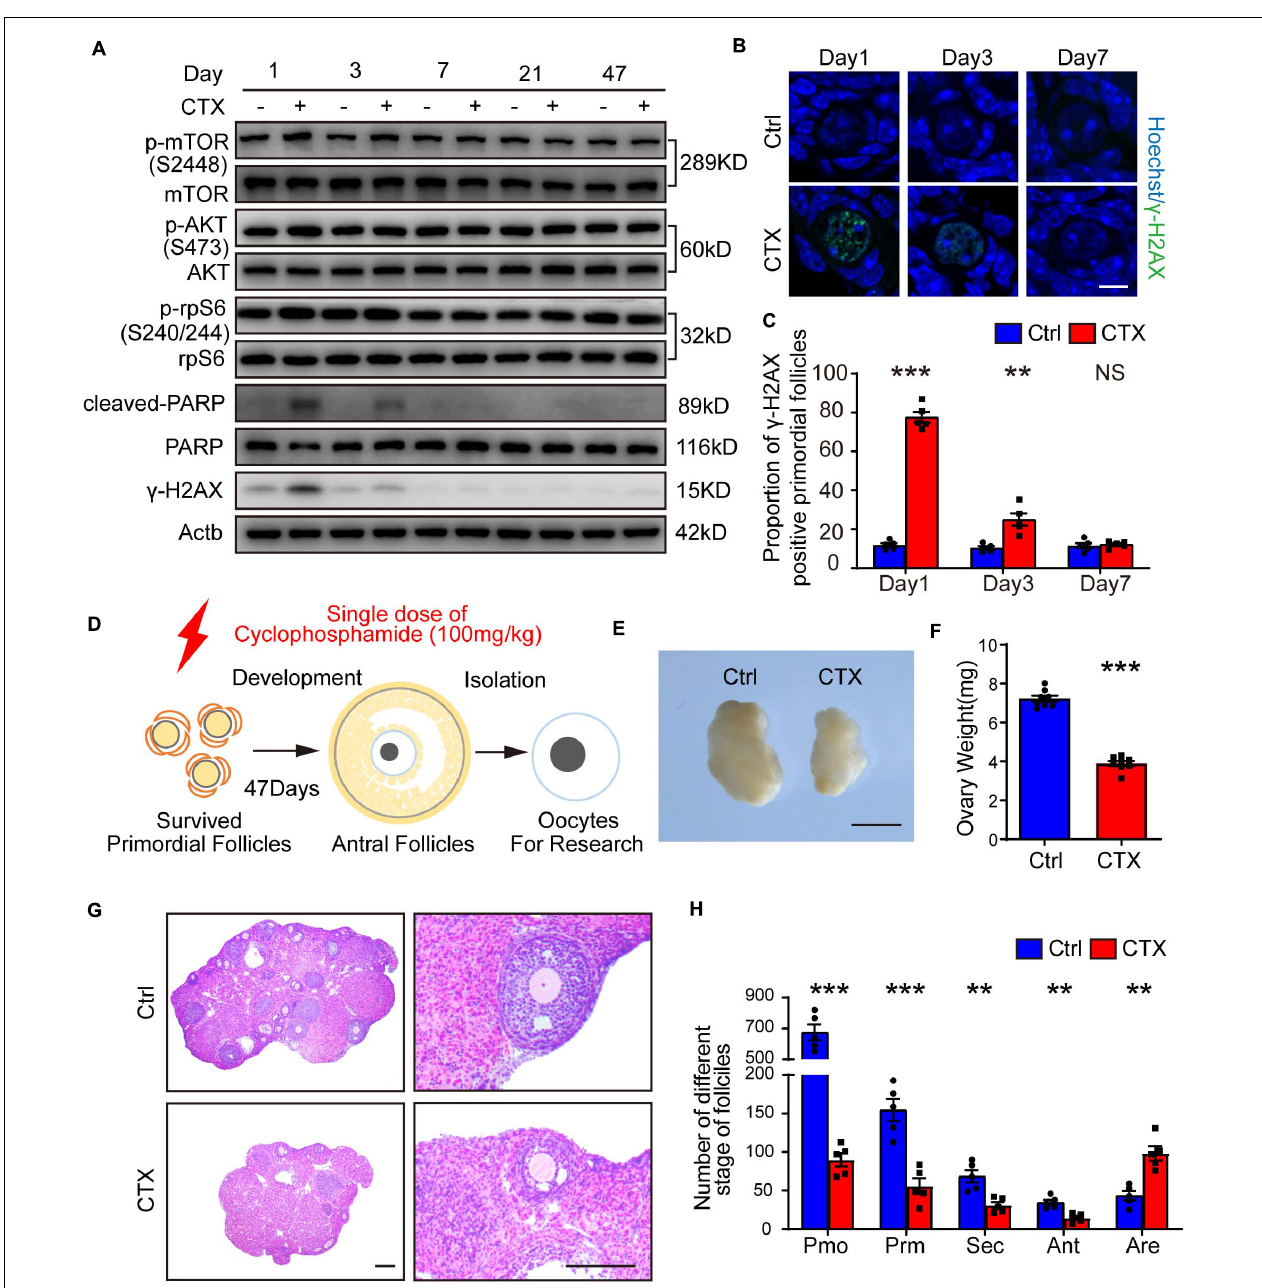
FIGURE 1 | CTX treatment caused activation and acute DNA damage of primordial follicles and impaired long-term follicle development. (A) Western blot analysis of dynamic alterations in the PI3K-AKT-mTOR signaling pathway, DNA damage marker γ -H2AX and apoptotic marker PARP. Ovary samples were collected after injection of CTX on days 1, 3, 7, 21, and 47. (B) Immunostaining of γ -H2AX in residual primordial follicles after CTX exposure. Scale bar = 10 µ m. (C) Statistical analysis of the proportion of γ -H2AX-positive primordial follicles in the residual follicle pool. (D) Graphical abstract of experiment design and time of oocyte collecting. (E) Morphology of ovaries collected after 47 days of exposure to CTX. Scale bar = 500 µ m. (F) Ovary weight decreased after 47 days of CTX treatment. (G) Histological analysis of ovary morphology and residual primordial follicles in the cortex. Scale bar = 100 µ m. (H) Statistical analysis of different stages of follicles with or without CTX treatment. Pmo, primordial follicle; Prm. primary follicle; Sec, secondary follicle; Ant, antral follicle; Are, atretic follicle. Data was presented as mean ± SEM. NS, no significant, ** P < 0.01, *** P < 0.001.